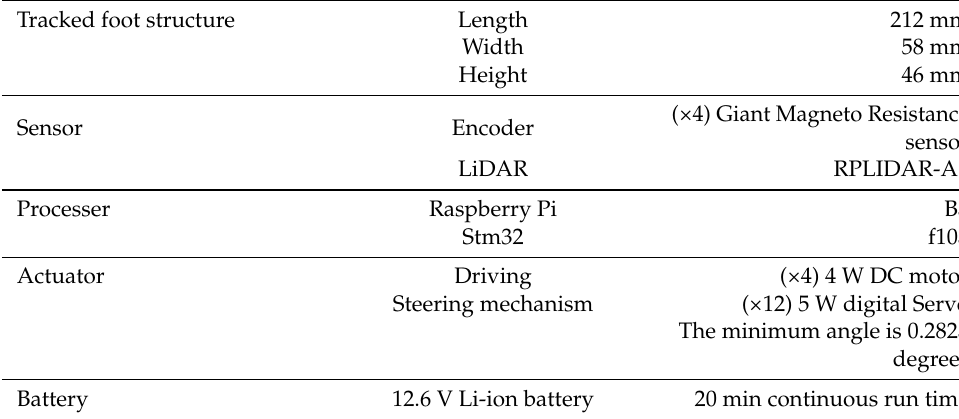
Table 2. Cont. Tracked foot